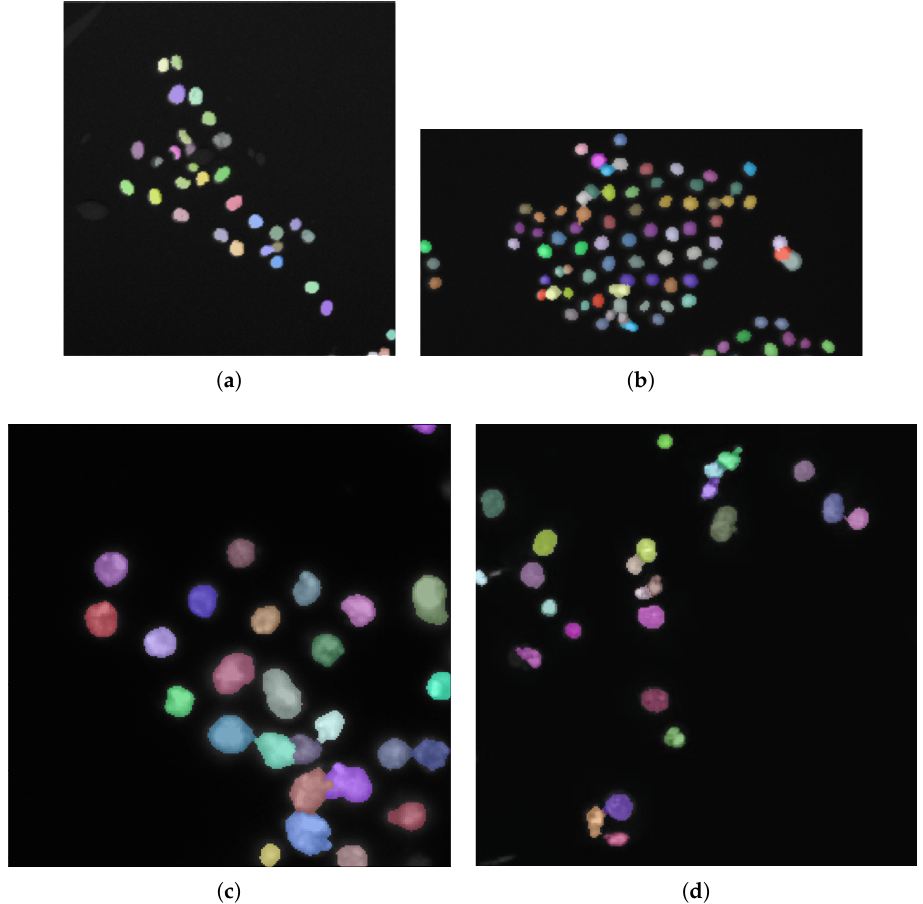
Figure 7. Examples of cell nuclei segmented by ACDC considering sub-images of Figure 1a,b ( a , b ), and the whole images in Figure 2a,b ( c , d ). The cell nuclei images were over-imposed onto the original fluorescence images with alpha-blending ( α =